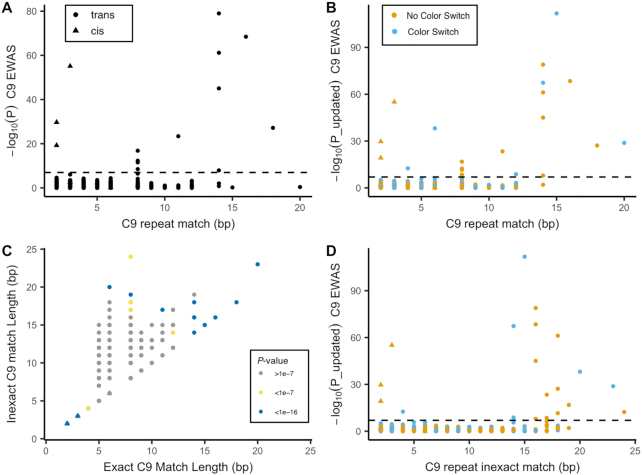
Comparison between P-values from the C9orf72 EWAS and match (bp) between the probe’s 3′-subsequence and the bisulfite-converted C9orf72 repeat (see Supplementary Figure S4 for type II probes). Here, we assumed that the repeat was completely methylated (i.e. all Cs converted to Ts, except C’s in CpG-sites). (A) Comparison between P-values from the C9 EWAS and match (bp) between the probe’s 3′-subsequence and the bisulfite-converted C9 repeat. (B) Comparison between the P-values (−log10(P), y-axis) from the C9 EWAS and match between the probe’s 3′-subsequence. P-values from the EWAS on OOB β-values were used in case of a predicted color channel switch (OOB probes). (C) Comparison between the length of the inexact match to the C9 repeat (y-axis) and exact match to the C9 repeat for type I probe sequences. Points are colored by significance levels in the C9 EWAS. (D) Comparison between the P-values (−log10(P), y-axis) from the C9 EWAS and inexact match between the probe’s 3′-subsequence. P-values from the EWAS on OOB β-values were used in case of a predicted color channel switch (OOB probes).